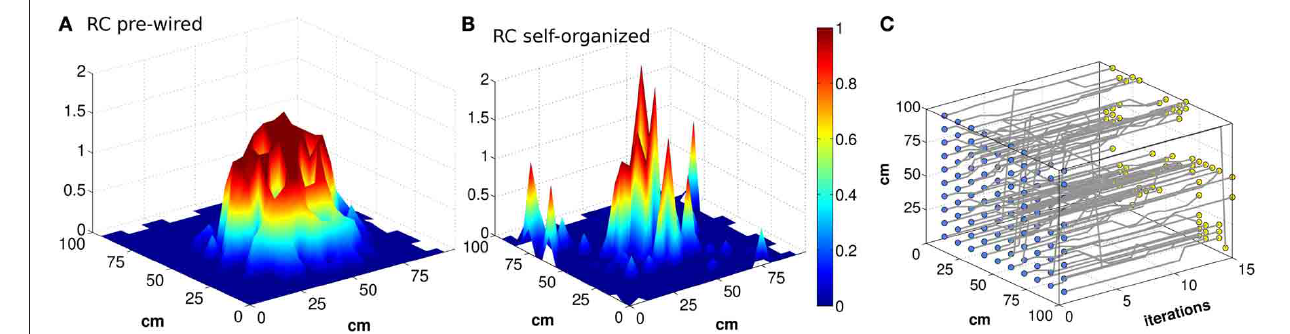
following an exponential function (A) is much smoother than in a network with connectivity resulting from a Hebbian self-organizing process (B) , both expressed when the DG input is turned off. The trajectory of the activity bump over 16 iterations is outlined for each initial position (C) (the iterations are taken to be included within one 125ms period during theta). The example in (C) is with pre-wired exponential